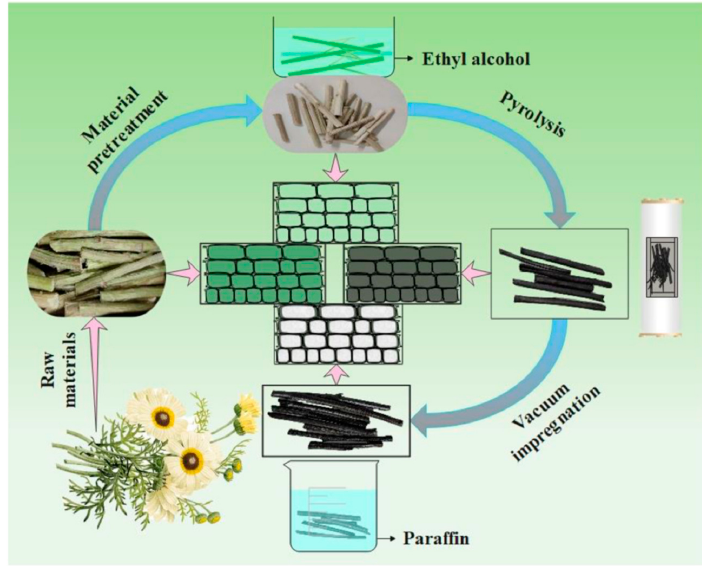
Figure 3. Preparation of composite PCMs with daisy stem and paraffin [52].